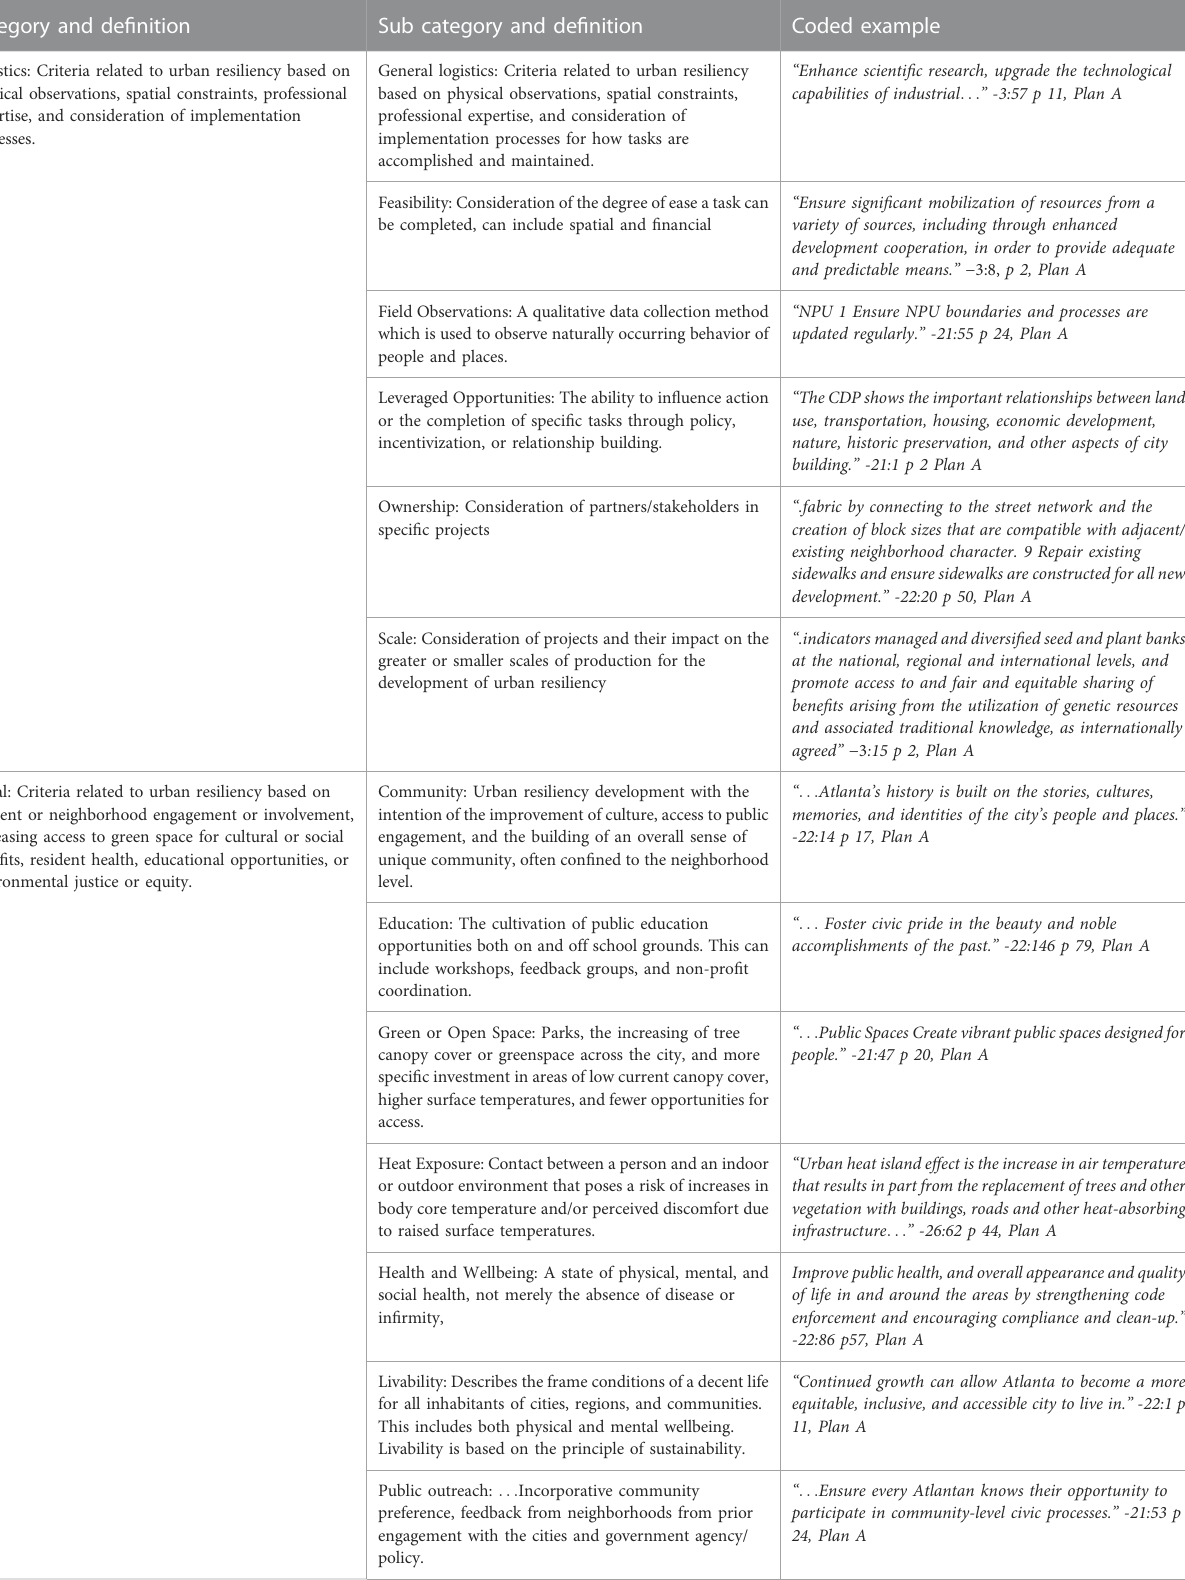
TABLE 1 ( Continued ) Comprehensive list of coding: categories, sub categories, de fi nitions, and examples of each from selected documents. Category and de fi